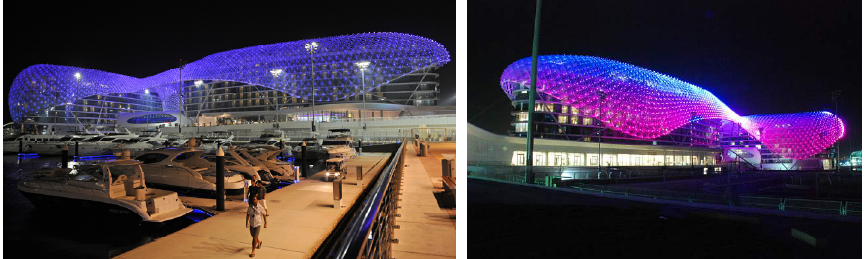
Figure 9a, b: Yas Island Marina Formula One Racetrack